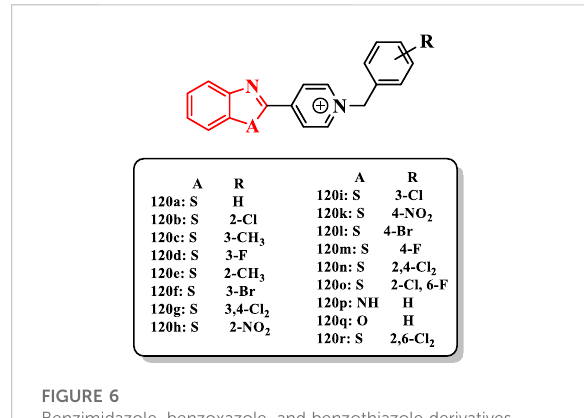
FIGURE 6 Benzimidazole, benzoxazole, and benzothiazole